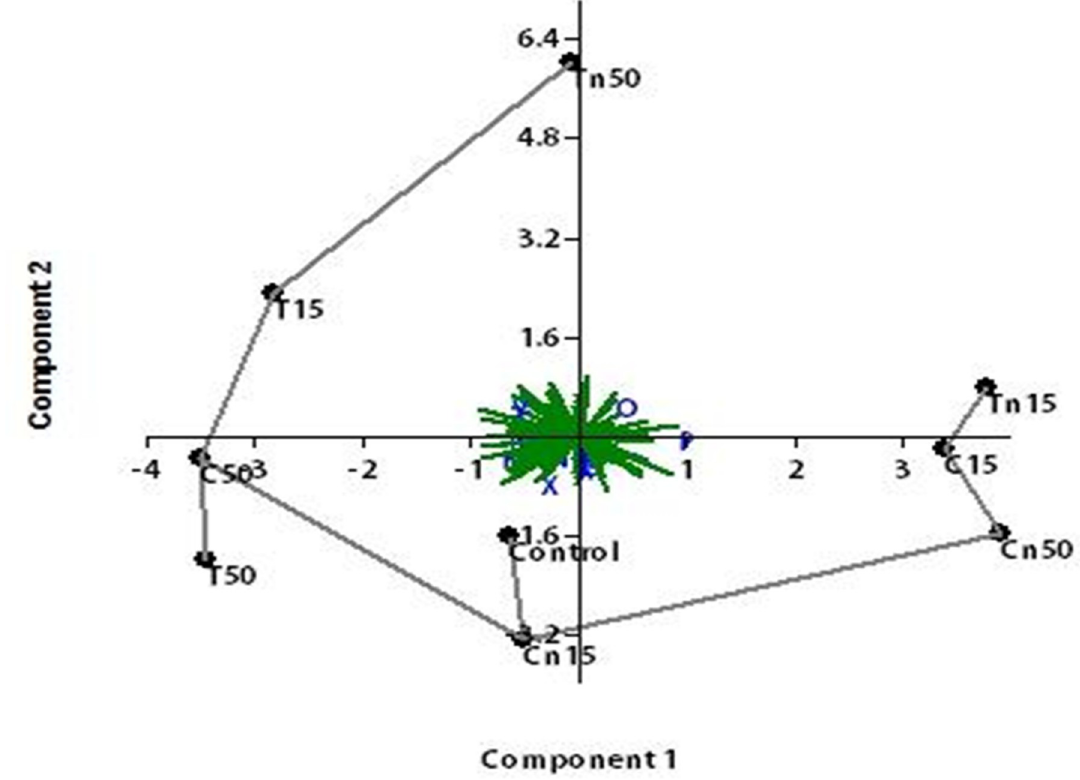
Fig 8. A representative agarose gel where PCR products of the 15 ISSR primers for the nine treatments.